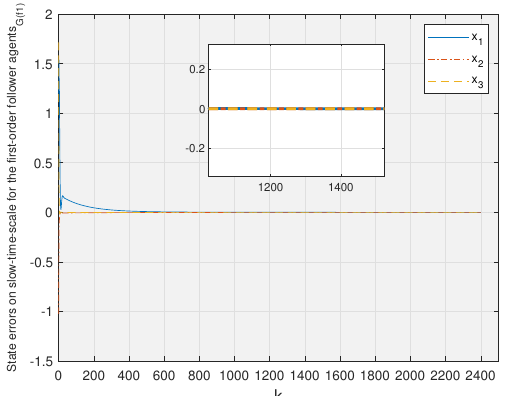
Figure 3. State errors on slow-time-scale for the first-order follower agents.